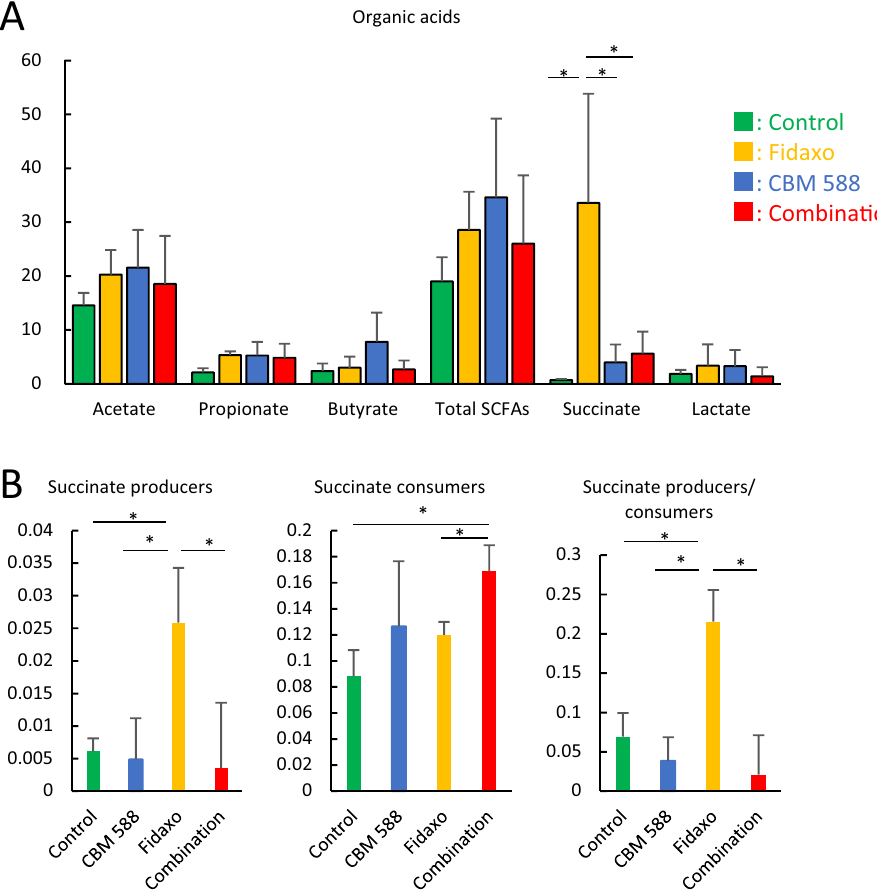
Figure 3. C. butyricum changed gut microbiome profiles to modulate gut succinate level. ( A ) Concentration of organic acids in fecal samples taken at day 4. (green: control group, yellow: fidaxomicin group, blue: CBM 588 group, red: combination group) All values are mean ± SD (n = 5–10). ( B ) Effect of fidaxomicin and CBM 588 administration on relative succinate producer and consumer species abundance in the fecal samples. Data represent the relative abundance (%) mean values of relative abundances ± SD (n = 5–10). Succinate producer: Propionibacterium spp., Alistipes spp., Paraprevotella spp., Parabacteroides spp., Blautia spp.,